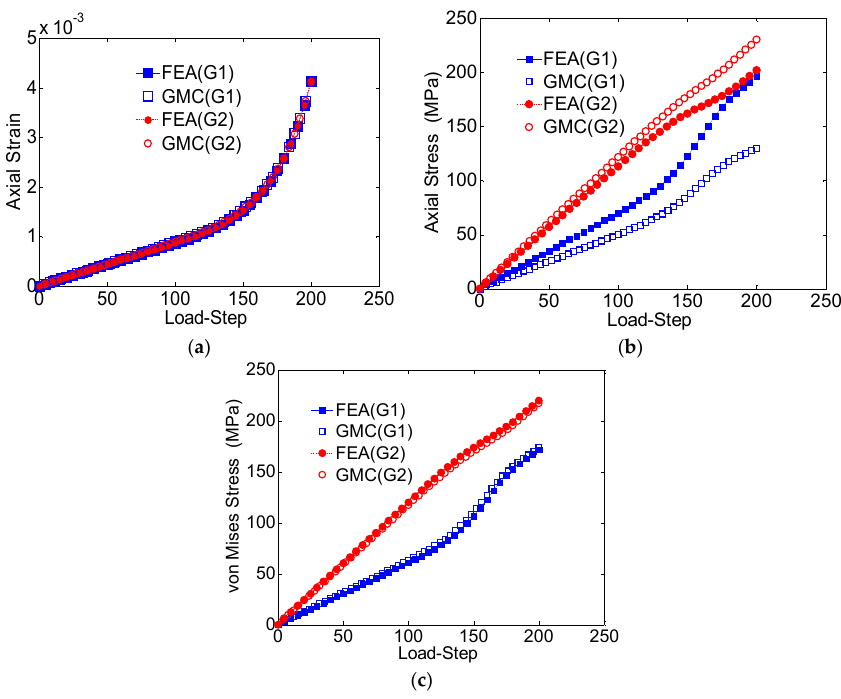
Figure 5. ( a ) Average axial strain ( ε zz ) vs . load-step; ( b ) average axial stress ( σ zz ) vs . load-step; ( c ) von Mises stress vs . load-step for the individual grains, Grain1 (G1) and Grain 2 (G2).